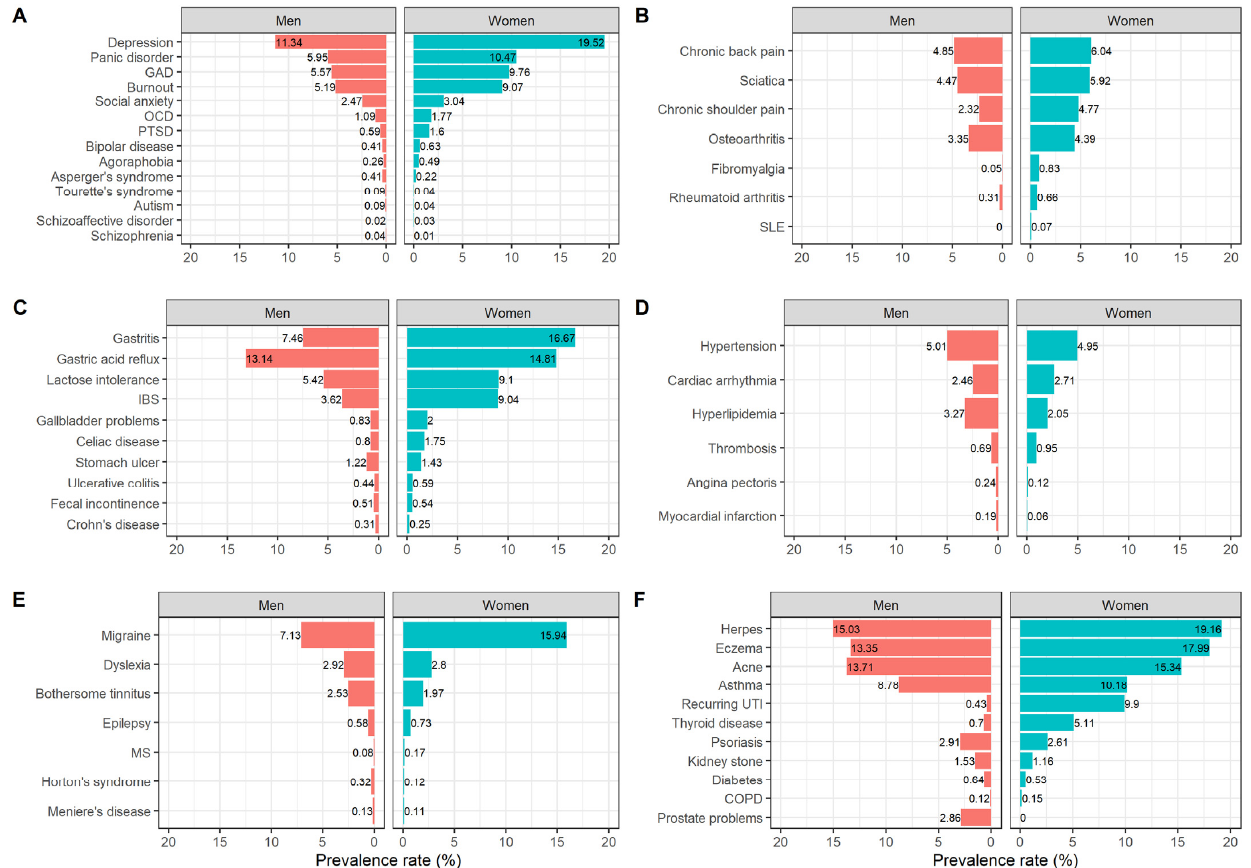
Figure 1. Prevalence rates (%) of psychiatric conditions ( A ), musculoskeletal diseases ( B ), digestive diseases ( C ), cardiovascular diseases ( D ), neurological diseases ( E ), and skin/pulmonary/ urogeni- tal/endocrine diseases ( F ) in male ( N = 11,949) and female ( N = 19,876) participants. Abbreviations: COPD = Chronic Obstructive Pulmonary Disease, IBS = Irritable Bowel Syndrome, UTI = Urinary Tract Infections, SLE = Systemic Lupus Erythematosus, MS = Multiple Sclerosis, GAD = Generalized Anxiety Disorder, OCD = Obsessive-Compulsive Disorder, PTSD = Posttraumatic Stress